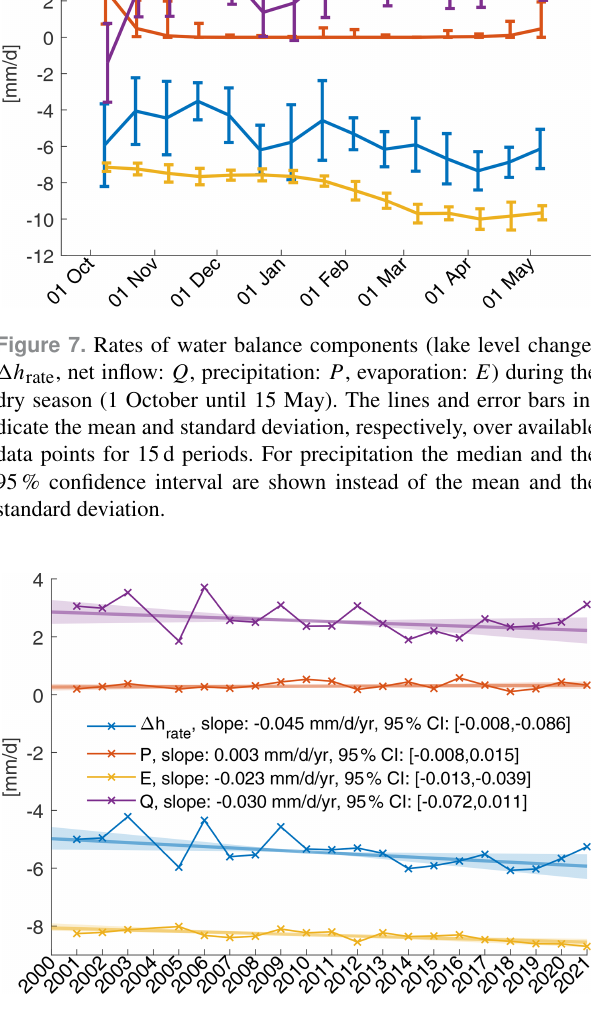
Figure 8. Average daily rates of water balance components esti- mated for the dry seasons in 2000–2021 (lake level change: (cid:49)h rate , net inflow: Q , precipitation: P , evaporation: E ). The transparent areas show the 95% CI of the linear regression